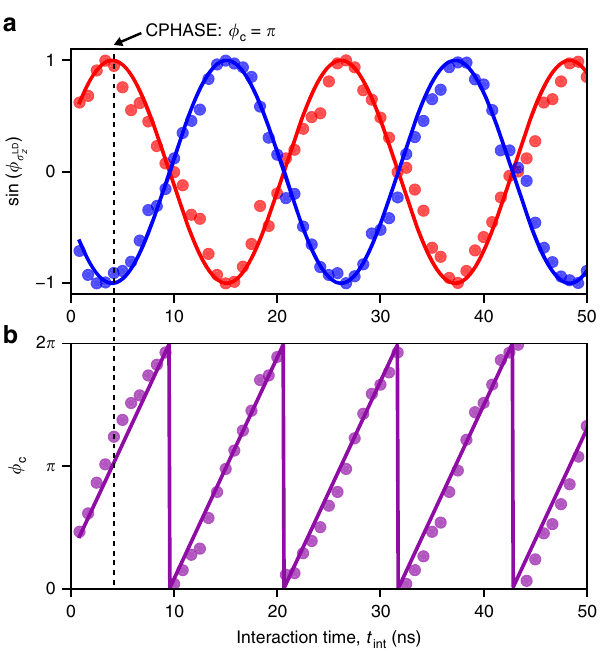
Fig. 3 Controlled-phase evolution. a Interaction time t int dependence of ϕ σ controlled by Q LD . The blue and red data are for Q LD = | ↑ 〉 and | ↓ 〉 , respectively. The solid curves are sin( π J QQ ( t int + t 0 )/ h ) (red) and sin ( − π J QQ ( t int + t 0 )/ h ) (blue) where the values of J QQ and t 0 are obtained in the MLE. The curves are consistent with the data as expected. b Controlled- phase ϕ C = ϕ | ↓ 〉 − ϕ | ↑ 〉 extracted from Fig. 3a. Including the initial phase accumulated during gate voltage ramps at stage F, ϕ C reaches π fi rst at t int = 4.0 ns and increases by π in every 5.5 ns afterwards